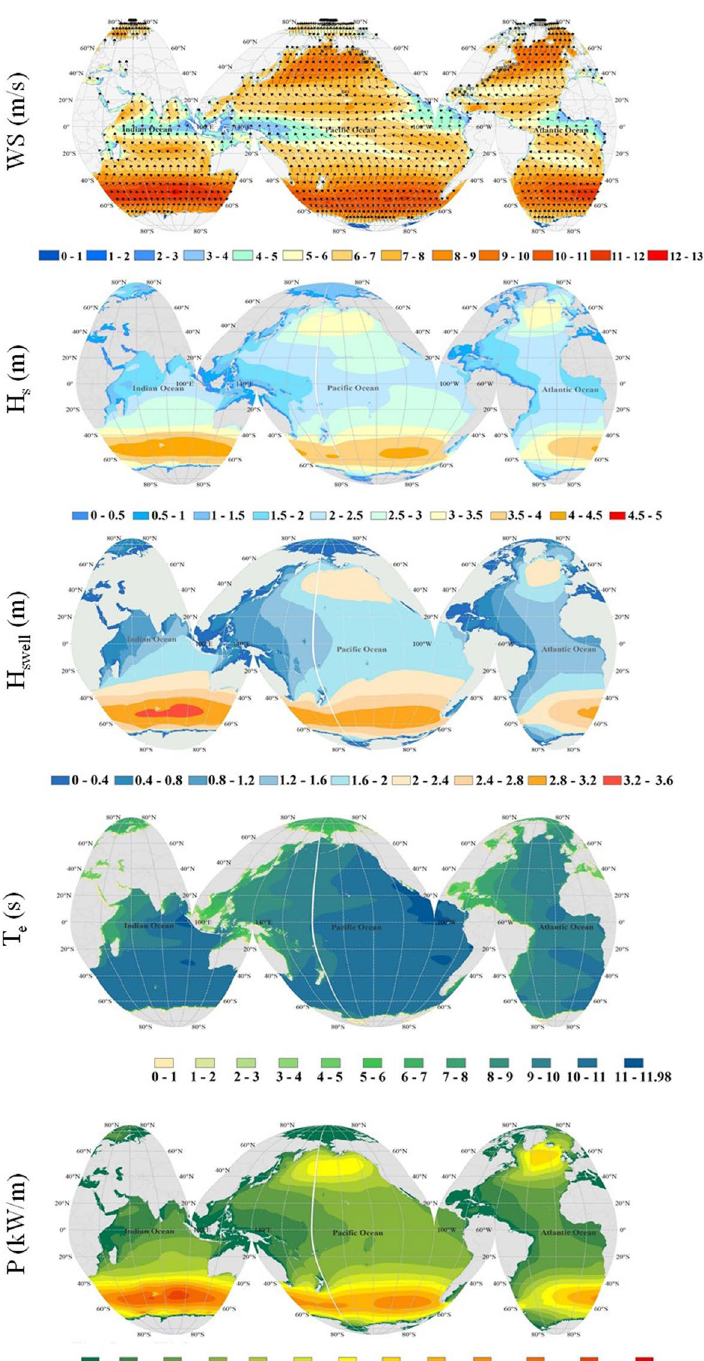
Figure 1. Annual mean values of different parameters in Per_1. The figure has been generated using ArcGIS 10.2 and Natural Earth-Free vector and raster map data @